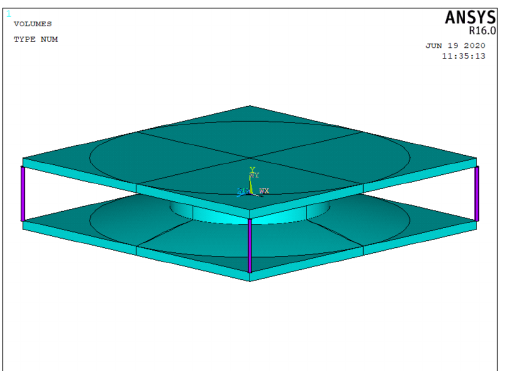
Figure 9. Finite element model of SMA-negative stiffness hyperboloid shock absorber. The bottom surface of the lower plate adopts fixed constraints. Before horizontal displacement loading, apply vertical pressure on the top surface of the upper plate. To keep the top plate of the device in a horizontal relationship with the bottom plate during the movement process, the Y-direction freedom of the nodes on the top surface of the upper plate is set up with centralized coupling, the Z-direction displacement is fixed, and the X-direction is applied with a reciprocating horizontal displacement load. The friction factor between the slider and the surface is taken as 0.02. To check the effect of the negative stiffness device, an SMA-negative stiffness hyperboloid shock absorber with a curved surface radius of 3 m was selected. A vertical load of 3000 kN is applied, and the loading curve is shown in Figure 10. The comparison of the restoring force-displacement hysteresis curves of the negative stiffness hyperboloid shock absorber and the SMA-negative stiffness hyperboloid shock absorber in the horizontal direction is shown in Figure 11. The hysteresis curve of the SMA negative stiffness hyperboloid shock absorber is very different from that of negative stiffness. First of all, the slope direction of the restoring force of the negative stiffness hyperboloid shock absorber is negative, and the slope direction of the restoring force of the SMA negative stiffness hyperboloid shock absorber is positive, which corresponds to the previous principle of the SMA negative stiffness hyperboloid shock absorber. The slope of the hysteresis curve of the negative stiffness hyperboloid shock absorber is negative, the slope of the SMA hysteresis curve is positive, and the slope of the hysteresis curve of the SMA negative stiffness hyperboloid shock absorber is the superposition of the two. It can also be seen from the figure that the maximum restoring force of the SMA negative stiffness hyperboloid shock absorber is greater than the maximum restoring force of the negative stiffness hyperboloid shock absorber. This is because SMA provides nonlinear restoring force, and SMA acts as a limiter